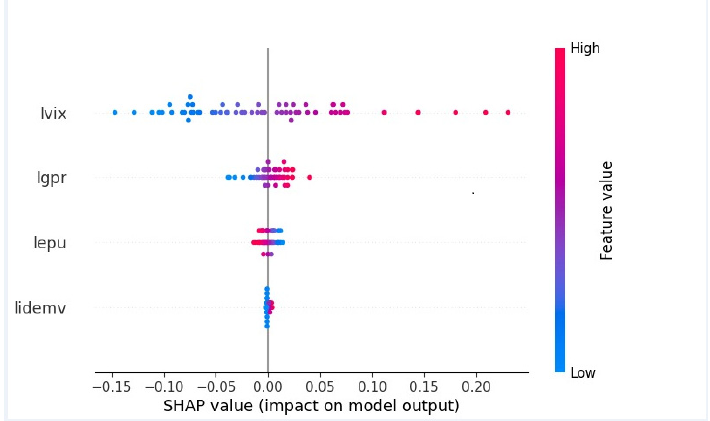
Figure 11. Feature importance before the pandemic—SVM model (Weekly frequency).